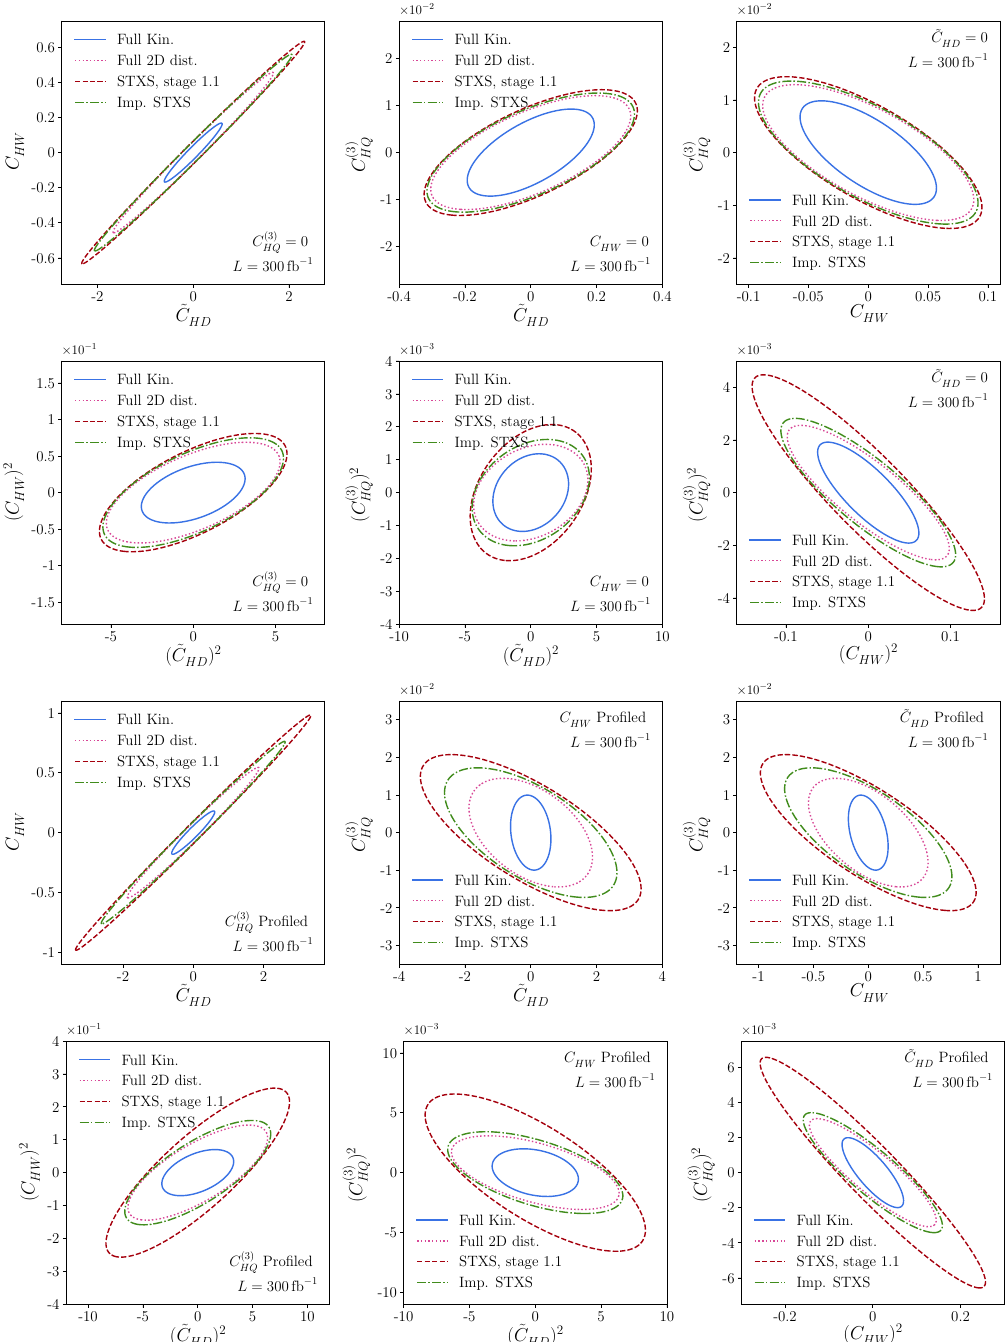
Figure 6 . As (cid:12)gure 5, now comparing various approaches: the solid blue curve shows the limits from training on the full phase space. The dotted pink line shows training only on the p T;W vs m T; tot histogram. The limits obtained from the STXS stage 1.1 are shown in dashed red, and the dot-dashed green curve shows the limits obtained by six p T;W bins subdivided into three m T; tot